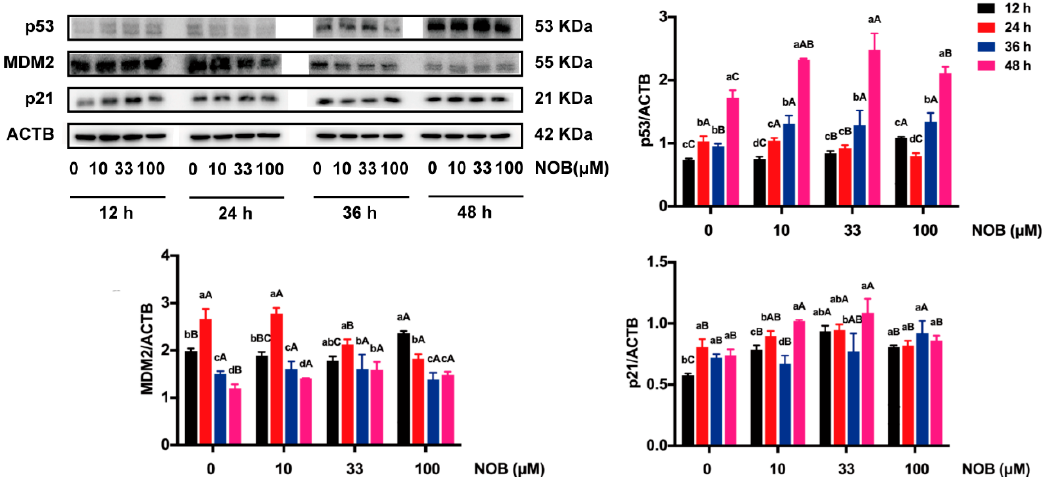
Figure 8. The effect of NOB on expressions of p53 pathway genes of BeWo cells. The protein expressions of p53, MDM2, and p21 were estimated by Western blot. ACTB was used as an internal control, and the relative protein expression was the ratio of target protein to ACTB. Data were summarized as mean ± SD, n = three independent experiments. At the same NOB treatment dose, different lowercase letters represent significant differences at different treatment times, p < 0.05. At the same treatment time, different capital letters represent significant differences at different NOB doses, p < 0.05, one-way ANOVA, using Duncan’s multiple range test.